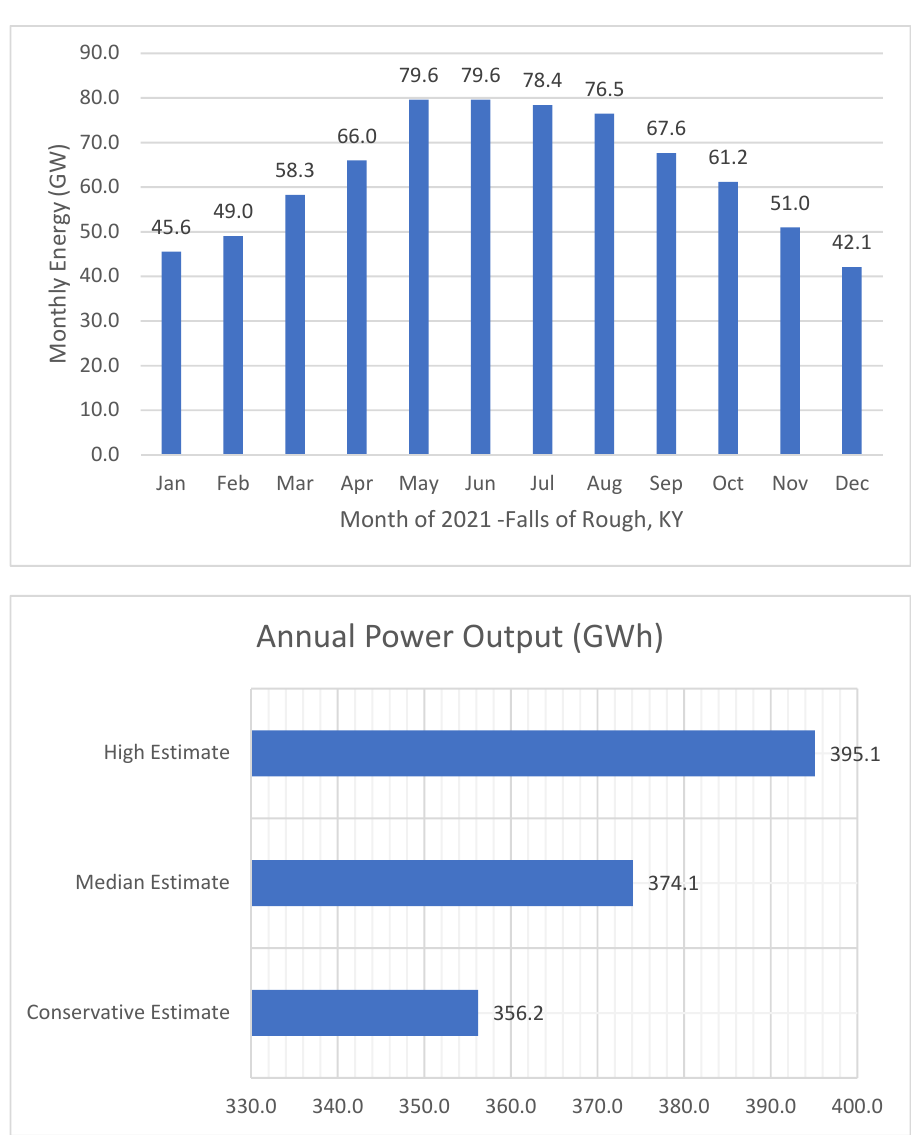
Figure 18. Graph of monthly average solar irradiance and array irradiance in kWh/m 2 for Falls of Rough, KY [27].